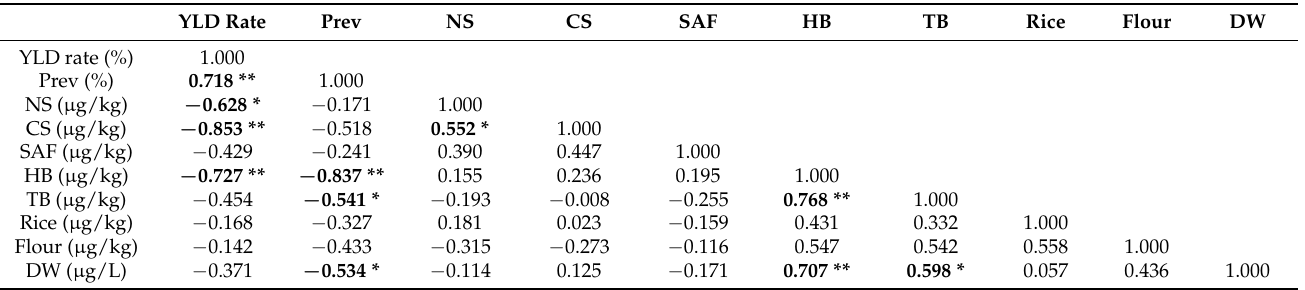
Table 3. Pearson correlation matrix of different